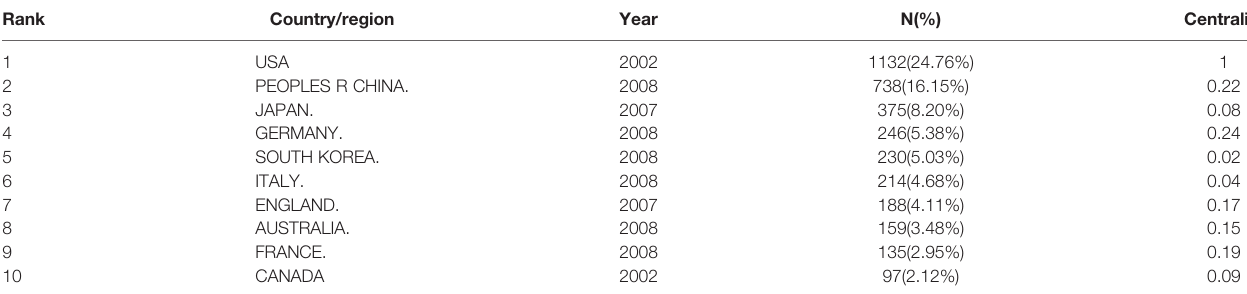
TABLE 3 | The top 10 countries/regions involved in osteoblasts-osteoclasts in bone disease research.